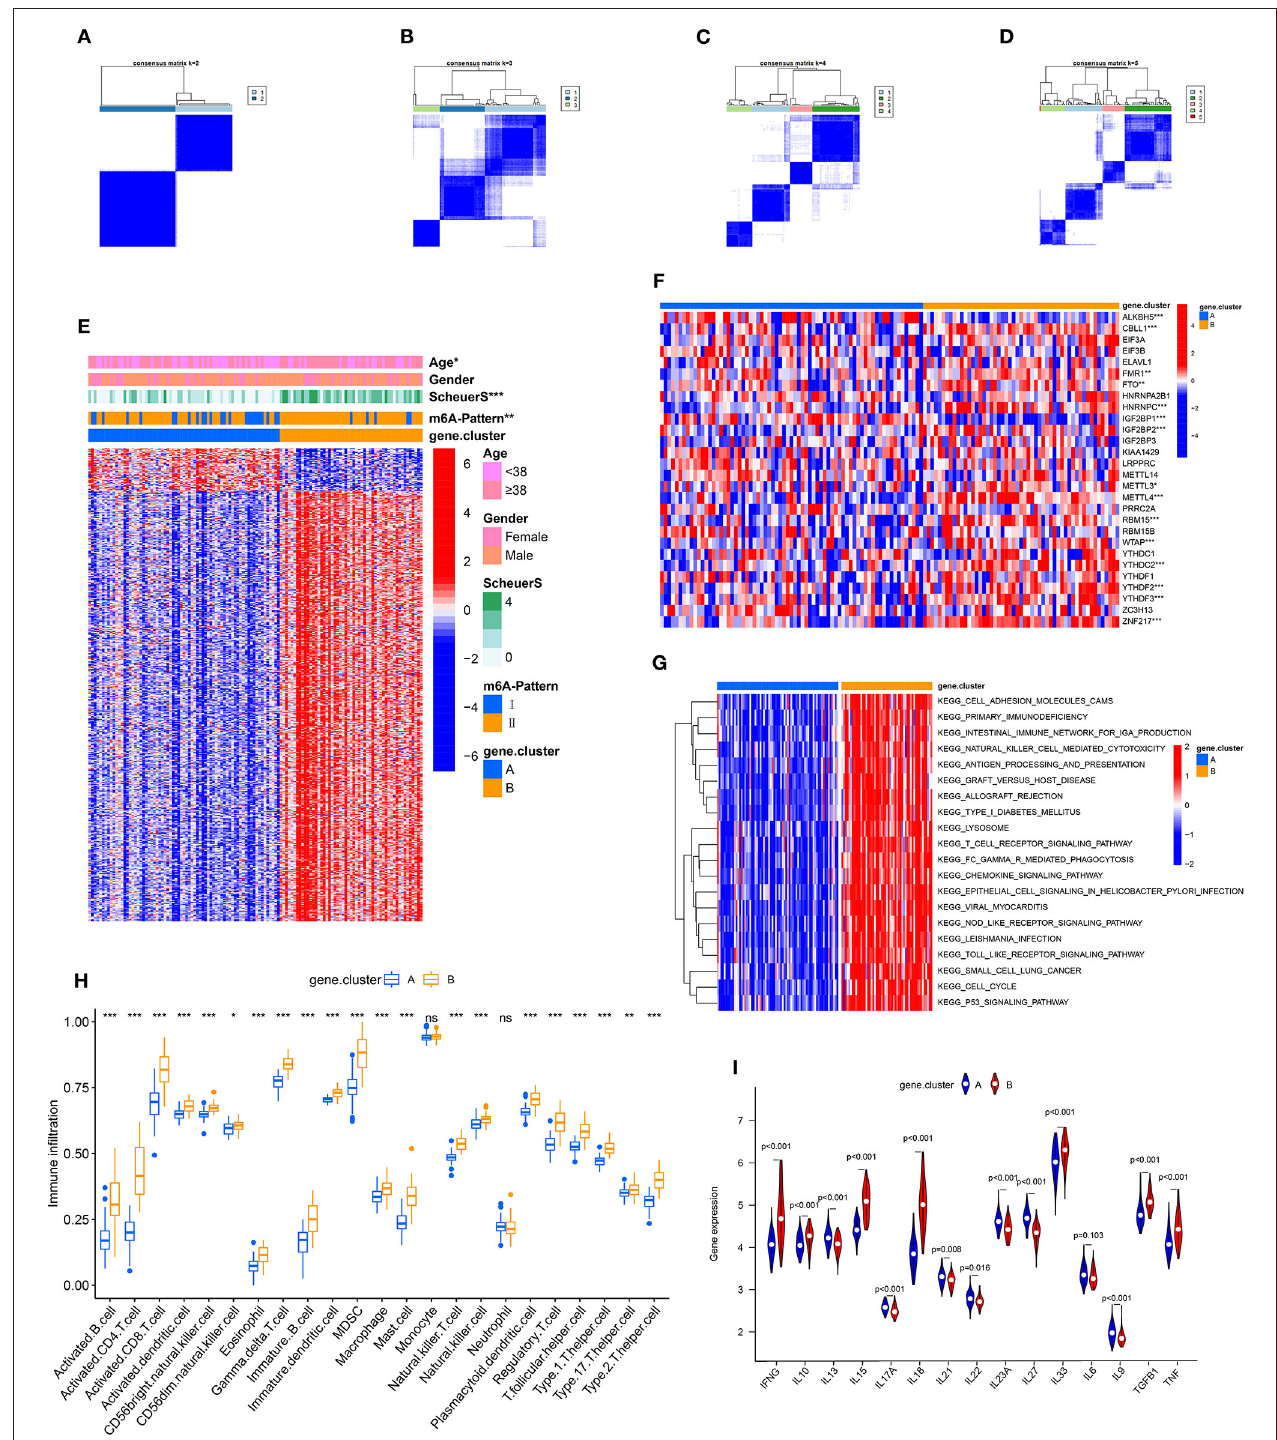
FIGURE 2 | Identification of m6A-and-stage related gene subtypes. (A–D) Consensus clustering of the 489 m6A-and-stage related genes for k = 2–5. (E) Heatmap of the 489 m6A-and-stage related genes and clinical traits in gene clusterA and gene clusterB. (F) Expression heatmap of the 28 m6A regulators in gene clusterA and gene clusterB. (G) The heatmap of gene set variation analysis (GSVA) enrichment analysis was used to visualize biological pathways between gene clusterA and gene clusterB. (H) Different immune cell infiltration of two gene clusters (I) Expression of cytokines between the two gene clusters (*** p < 0.001; ** p < 0.01; * p < 0.05).